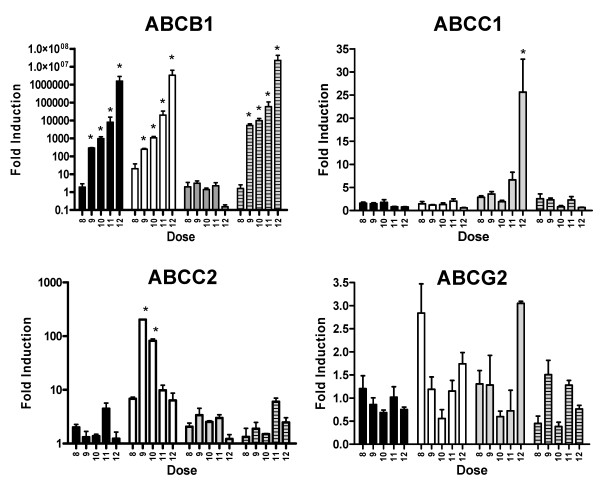
Levels of drug transporters at various selection doses in cells selected for progressive resistance to paclitaxel, docetaxel, doxorubicin, and epirubicin (MCF-7TAX-2, MCF-7TXT, MCF-7DOX-2, and MCF-7EPI cells, respectively). MCF-7TAX-2, MCF-7TXT, MCF-7DOX-2, and MCF-7EPI cells are represented by black, white, grey, and grey striped bars, respectively. The symbol * denotes changes in gene expression that vary significantly from levels in cells selected to dose 8 (p < 0.05).